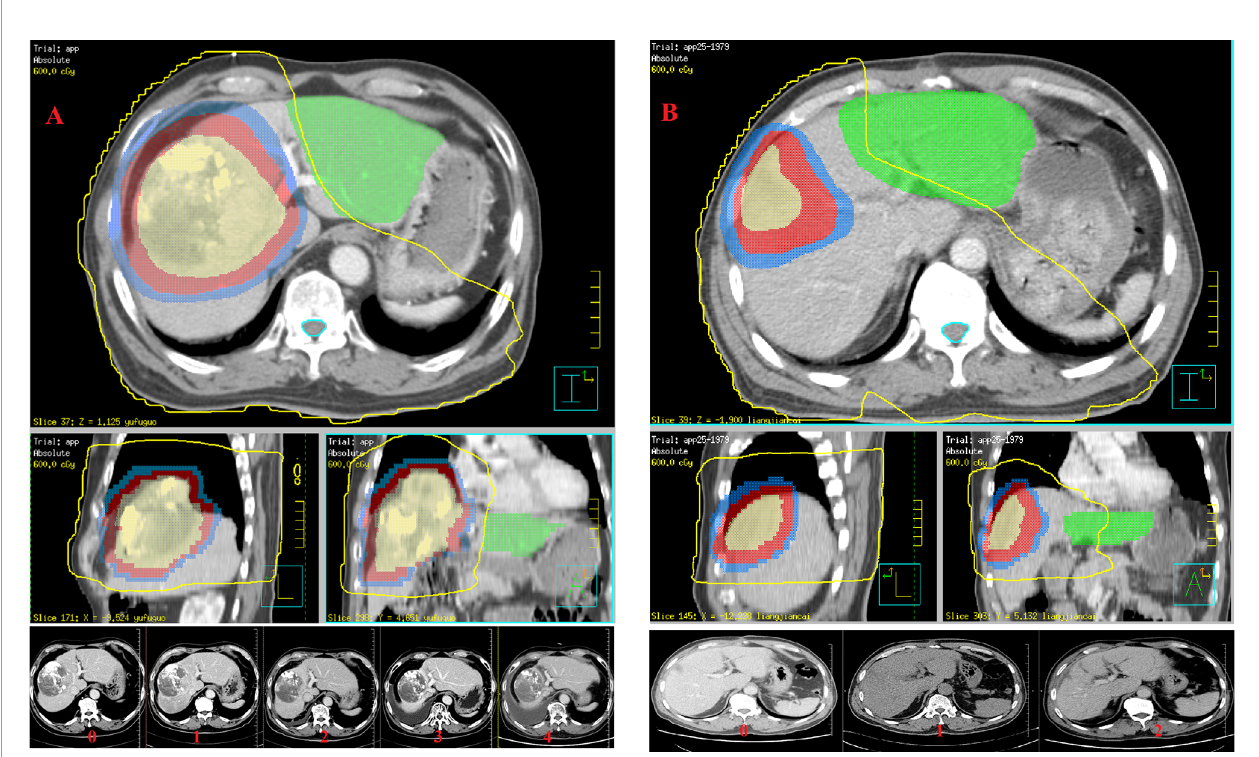
FIGURE 1 | Su ’ S radiotherapy target area delineation promotes liver regeneration and evaluation of liver regeneration after radiotherapy: (A) the training cohort (GTVi, PGTV and PCTV are shown from inside to outside, and the green part represents liver protected volume in preoperative downstaging radiotherapy plan); and (B) the testing cohort (GTVtb, PCTV1 and PCTV2 are shown from inside to outside, and the green part represents liver protected volume in postoperative adjuvant radiotherapy